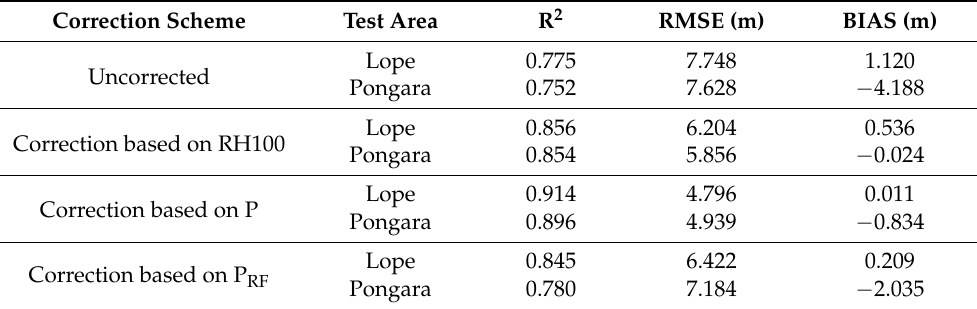
Table 6. Comparison of the results of different correction